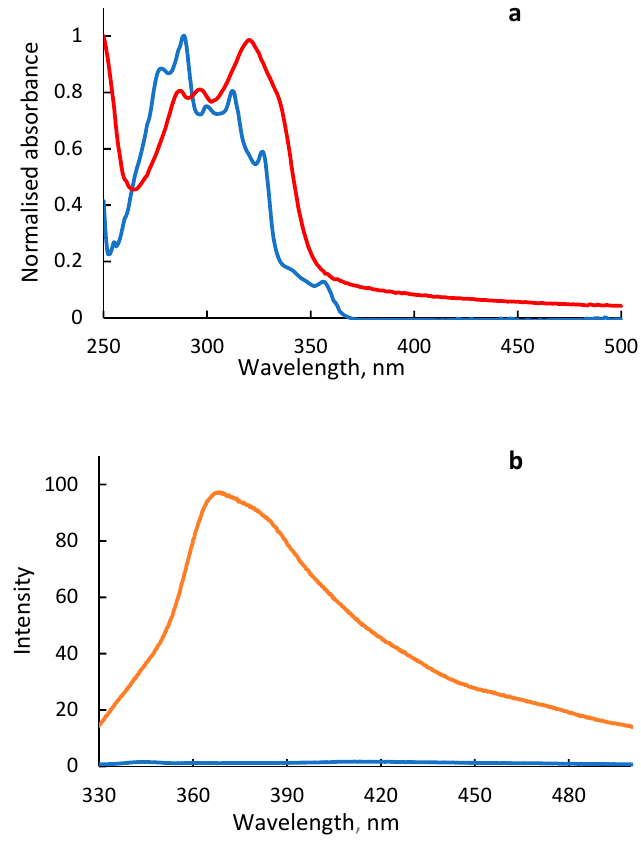
Figure 10. ( a ) The normalised absorption spectra of 4-aminocoumarin (c = 1.76 × 10 − 5 M, blue) and derivative 3 (c = 1.84 × 10 − 6 M, red) in CHCl 3 ; ( b ) with a comparison of the intensity of the fluorescence spectra of 4-aminocoumarin (orange line) and derivative 3 (blue line) in CHCl 3 ( λ exc = 310 nm, A = 0.2).